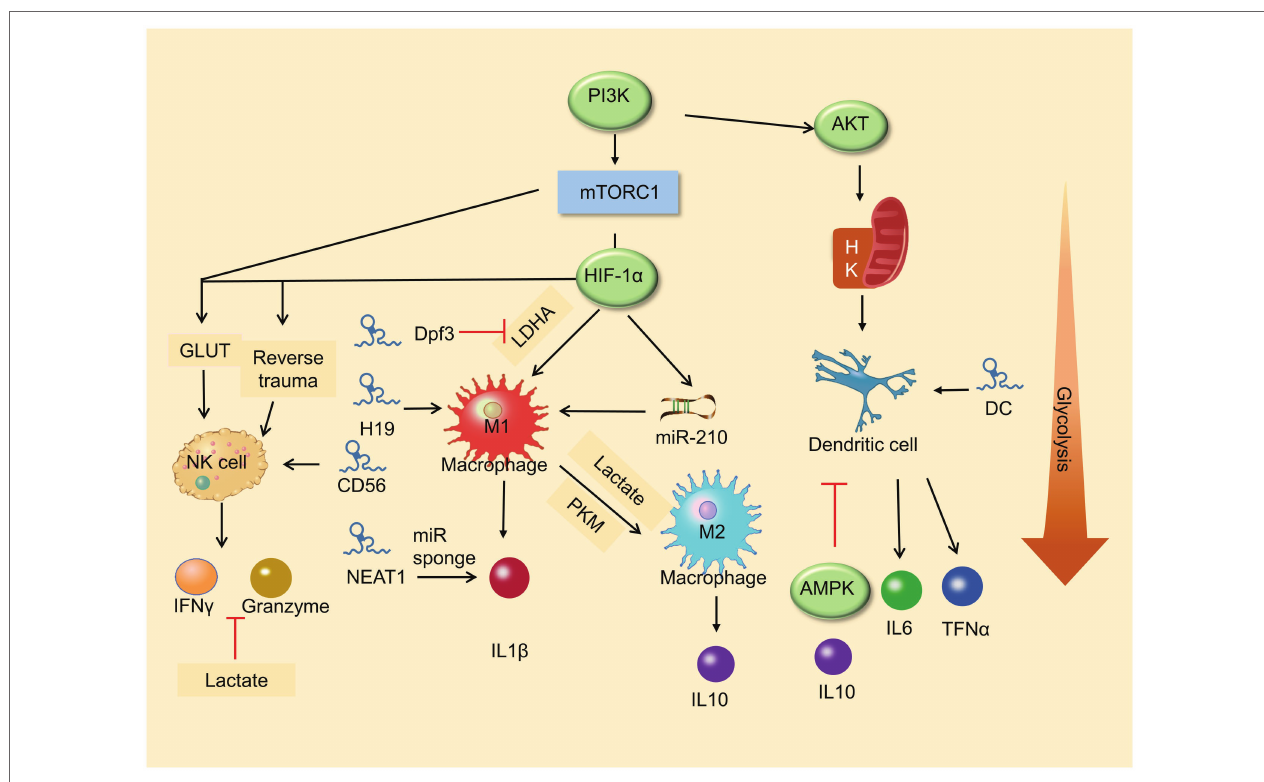
FIGURE 2 | Roles of metabolic pathway and lncRNA in immune cell differentiation. Glycolysis enhances macrophage M1 polarization and promises the function of NK cells. LncRNAs play a vital role in immune cells in differentiation and